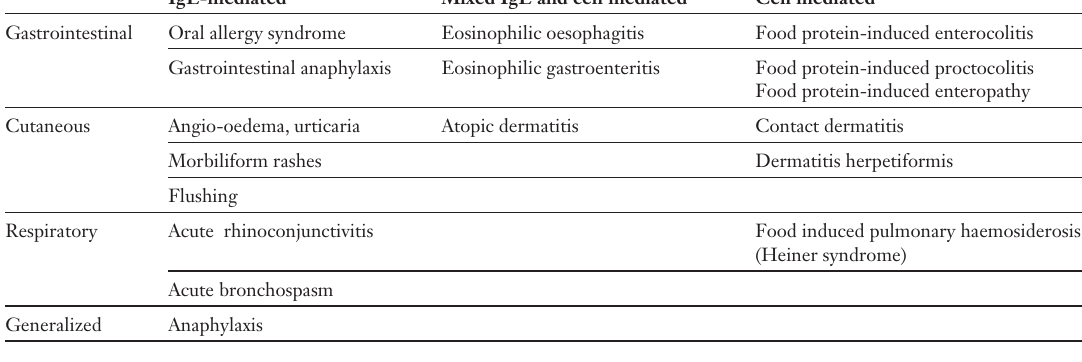
Food Allergies. Adapted from Sampson HA